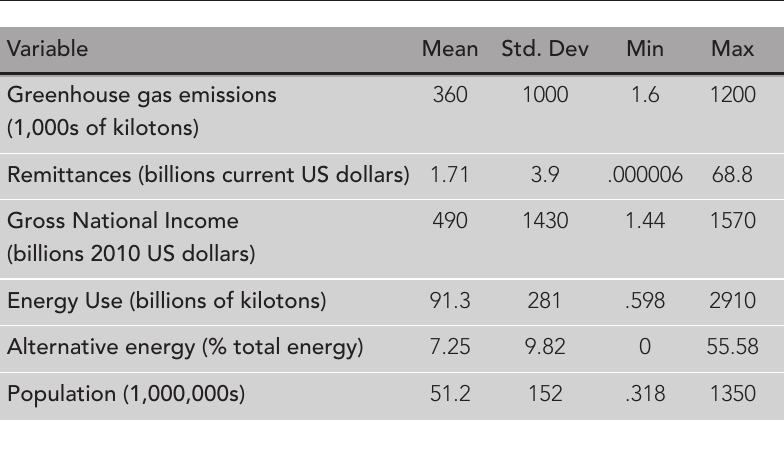
Table 1. Summary Statistics